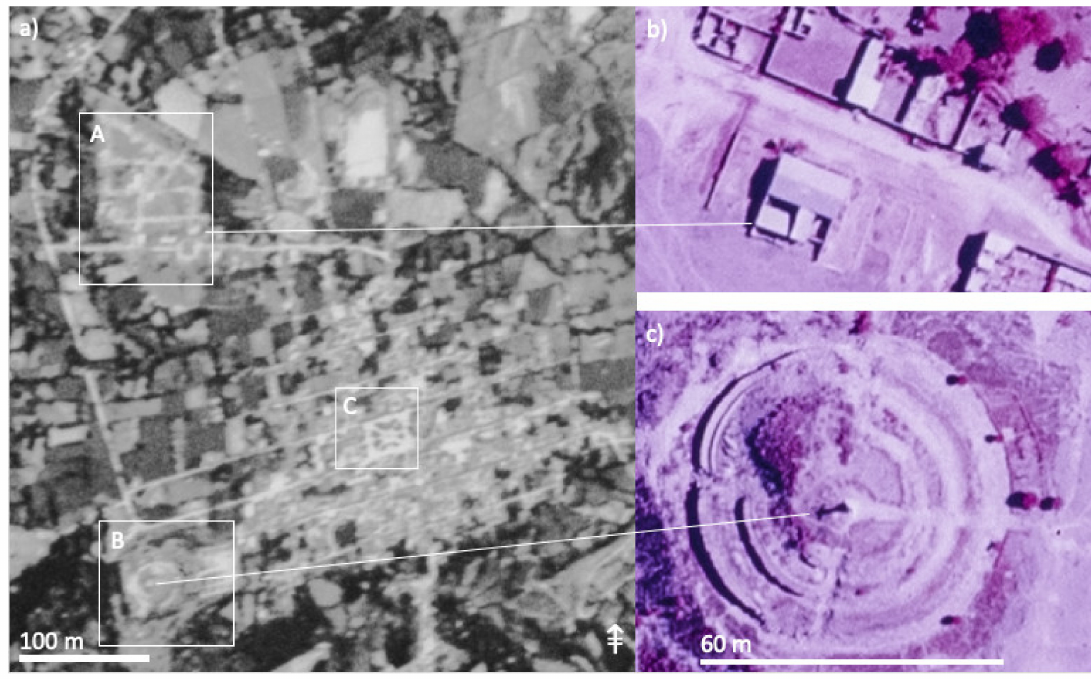
Figure 9. Detail of Yungay city, Peru in ( a ) KH-4A image from 1966 with an aerial image from 1970 in comparison ( b , c ), showing limits of spatial resolution (Data: Table